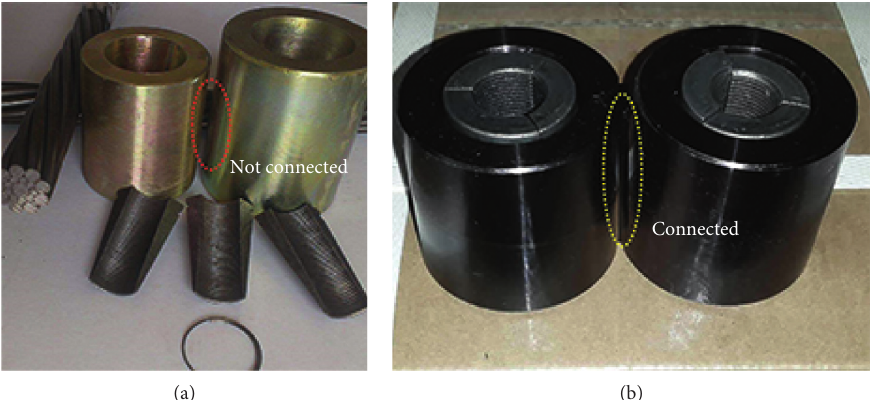
Figure 12: Views of the fastener of new and old supporting anchor cable. (a) Single anchor cable lock. (b) Truss anchor cable connector.